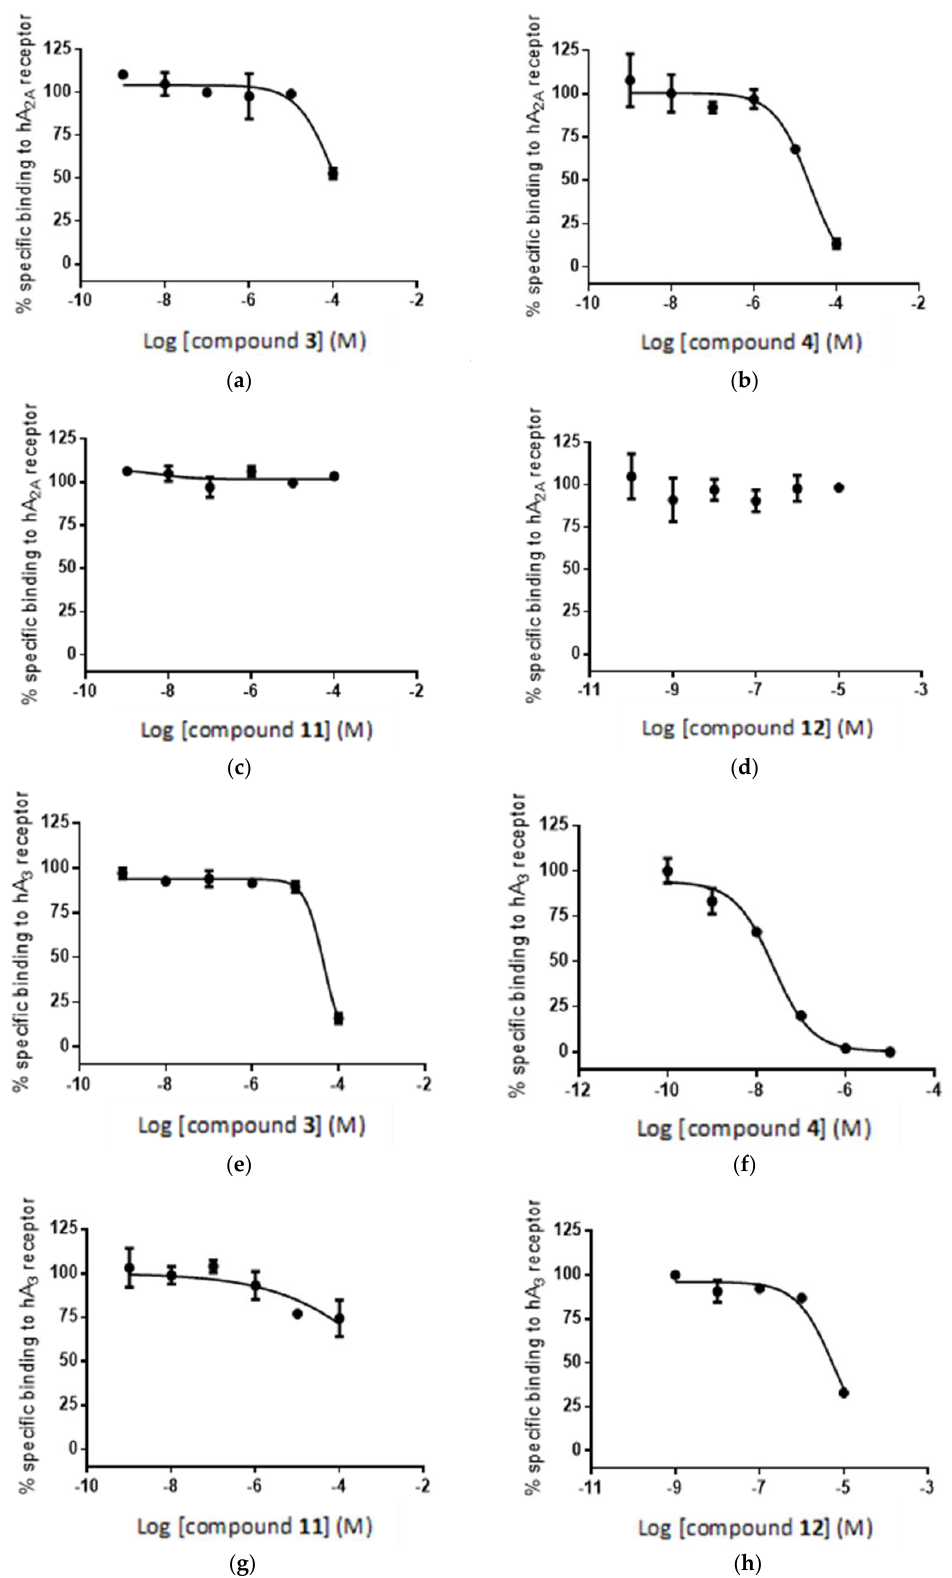
Figure 11. Radioligand competition binding assay: specific binding of compounds 3 , 4 , 11 and 12 to the adenosine receptors A2A ( a – d ) and A3 ( e – h ) (see Experimental Section).